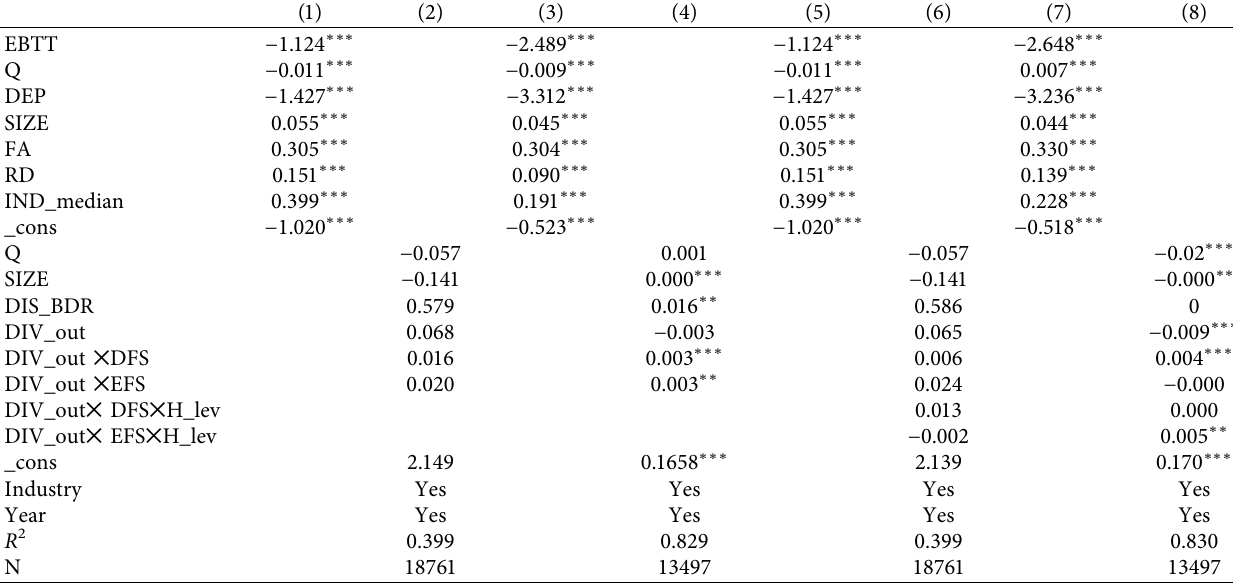
Table 5: The effect of dividend distribution and specific financing types to the adjustment of capital structure.